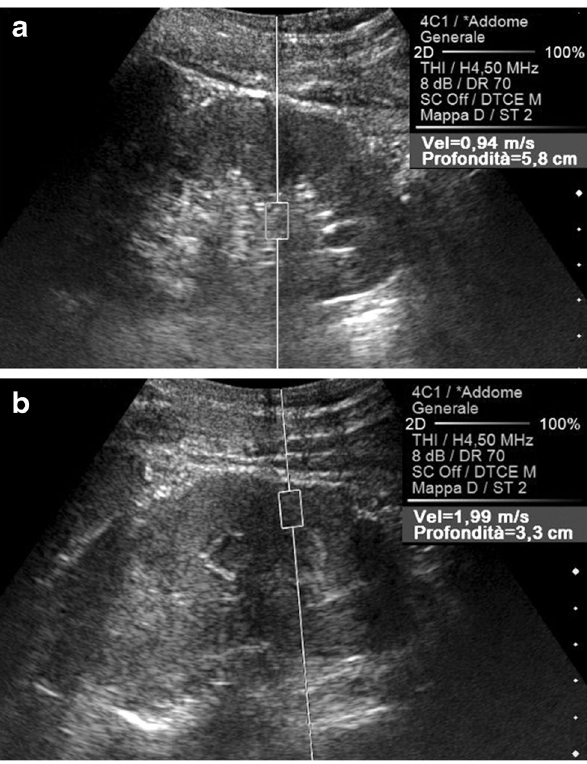
Fig. 7 Effect of anatomy on the speed of propagation of the shear waves. Oblique US scans on the right kidney in a healthy subject. A lower SWV value (0.94 vs. 1.99 m/s) is measured in the renal sinus ( a ) compared to in the parenchyma ( b )